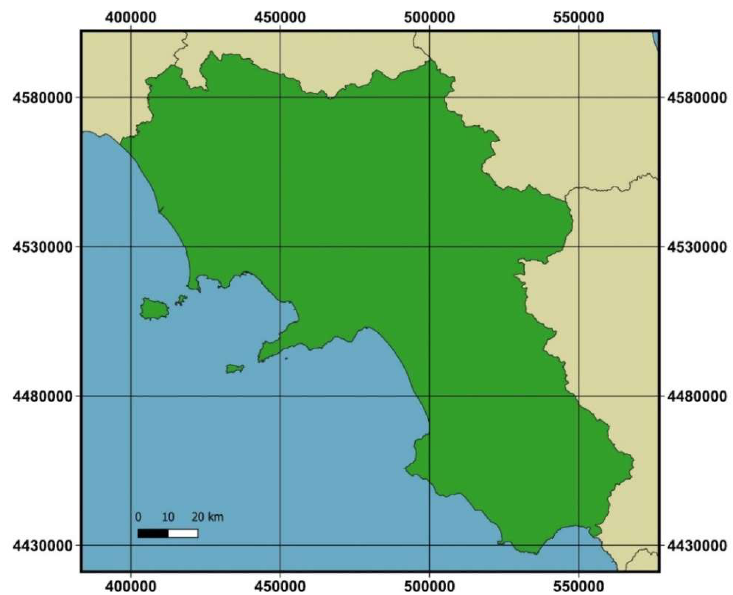
Figure 6. The clipped vector layer of administrative bounders.